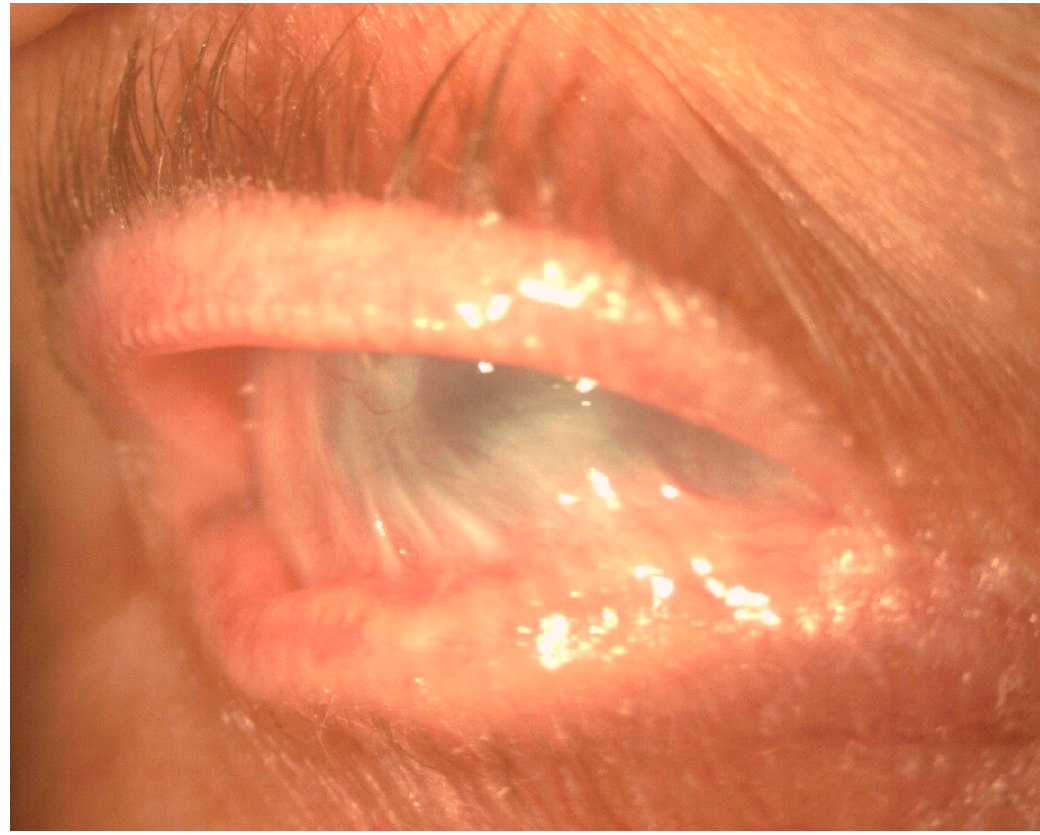
Figure 2. Slit-lamp image showing severe conjunctival fibrosis with symblepharon and corneal scarring in